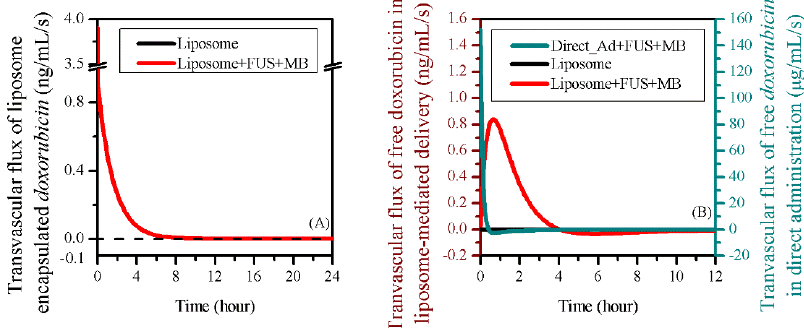
Figure 7. The transvascular flux of ( A ) liposome-encapsulated doxorubicin and ( B ) free doxorubicin between IVS and ECS in the brain tumour.